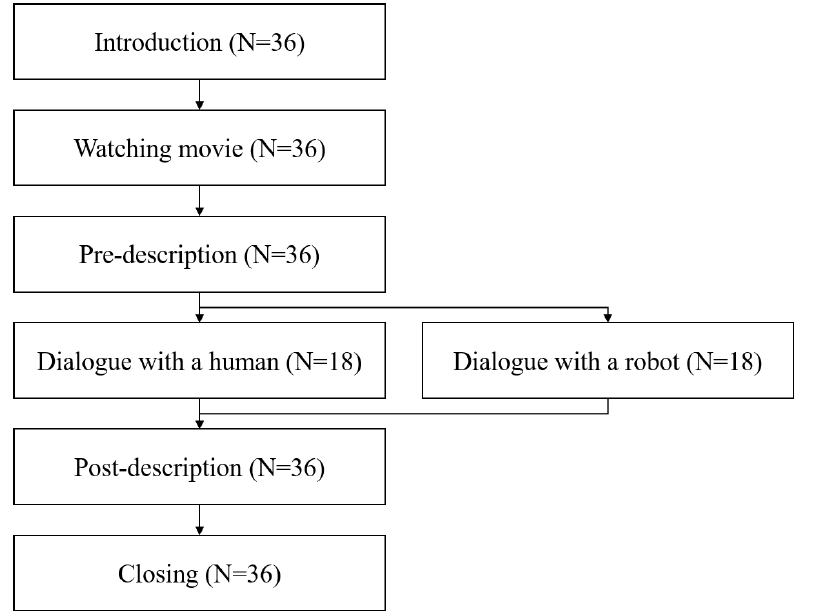
Figure 2. Experimental